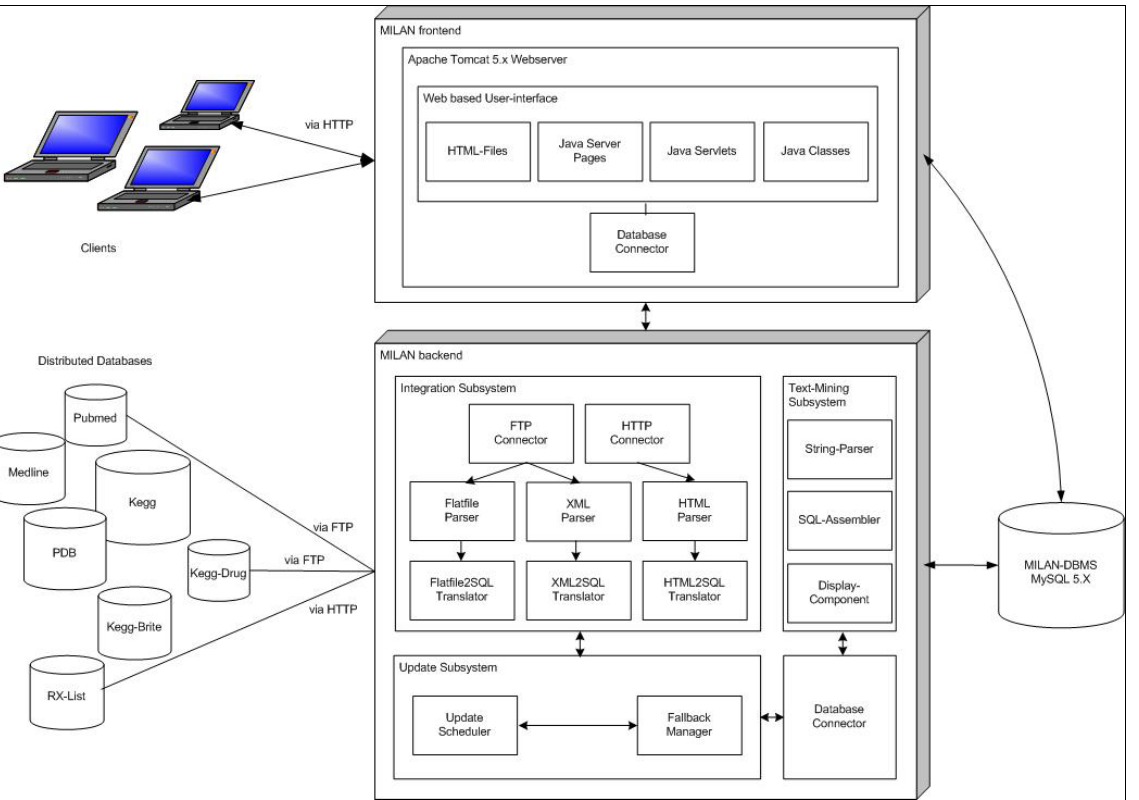
Figure 3: The figure shows the complete MILAN system structure. MILAN consists of three parts. The core system functionality is provided through the backend-system. It contains three subsystems which integrate all required data, control the updating process, react on integration failures and implement the textmining feature. The MILAN-frontend provides the web-based user GUI which processes the user queries and sends them as SQL-statements to the database. The third part is the actual database management-system which contains all gathered